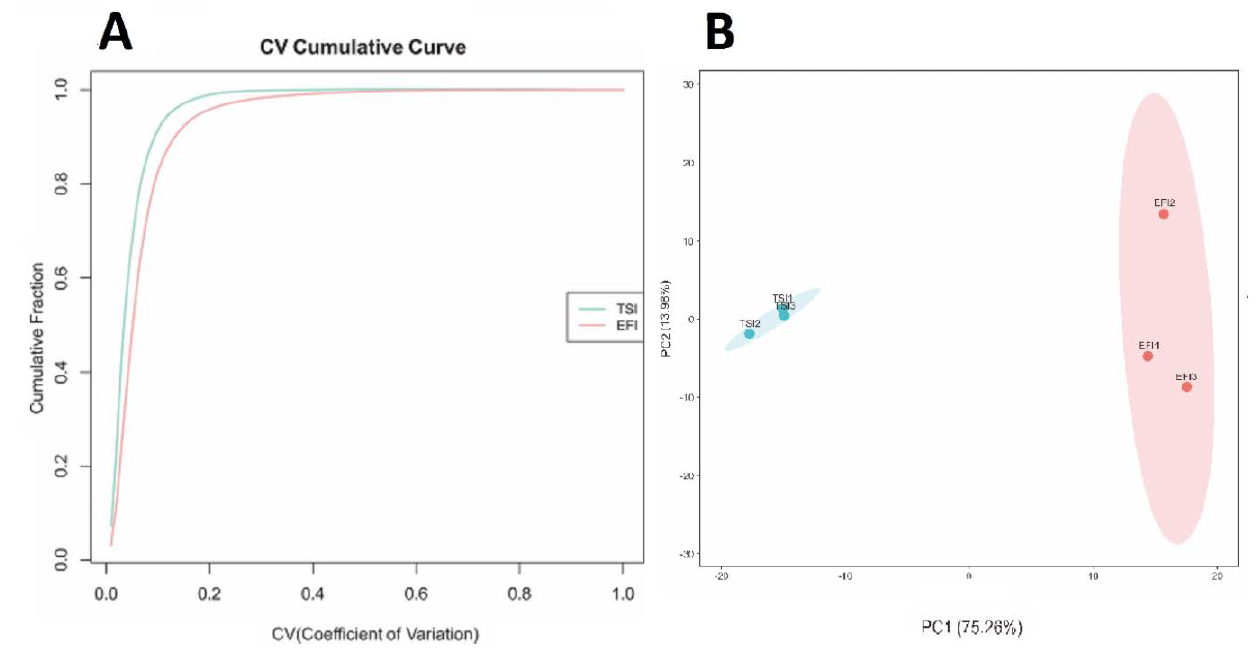
Figure 3. Scatter plot of CV (coefficient of variation) distribution and PCA (principal component analysis) of all samples using quantified proteins. ( A ) CV cumulative curve of two treatments. ( B ) Two-dimensional scatter plot of PCA distribution of all samples.